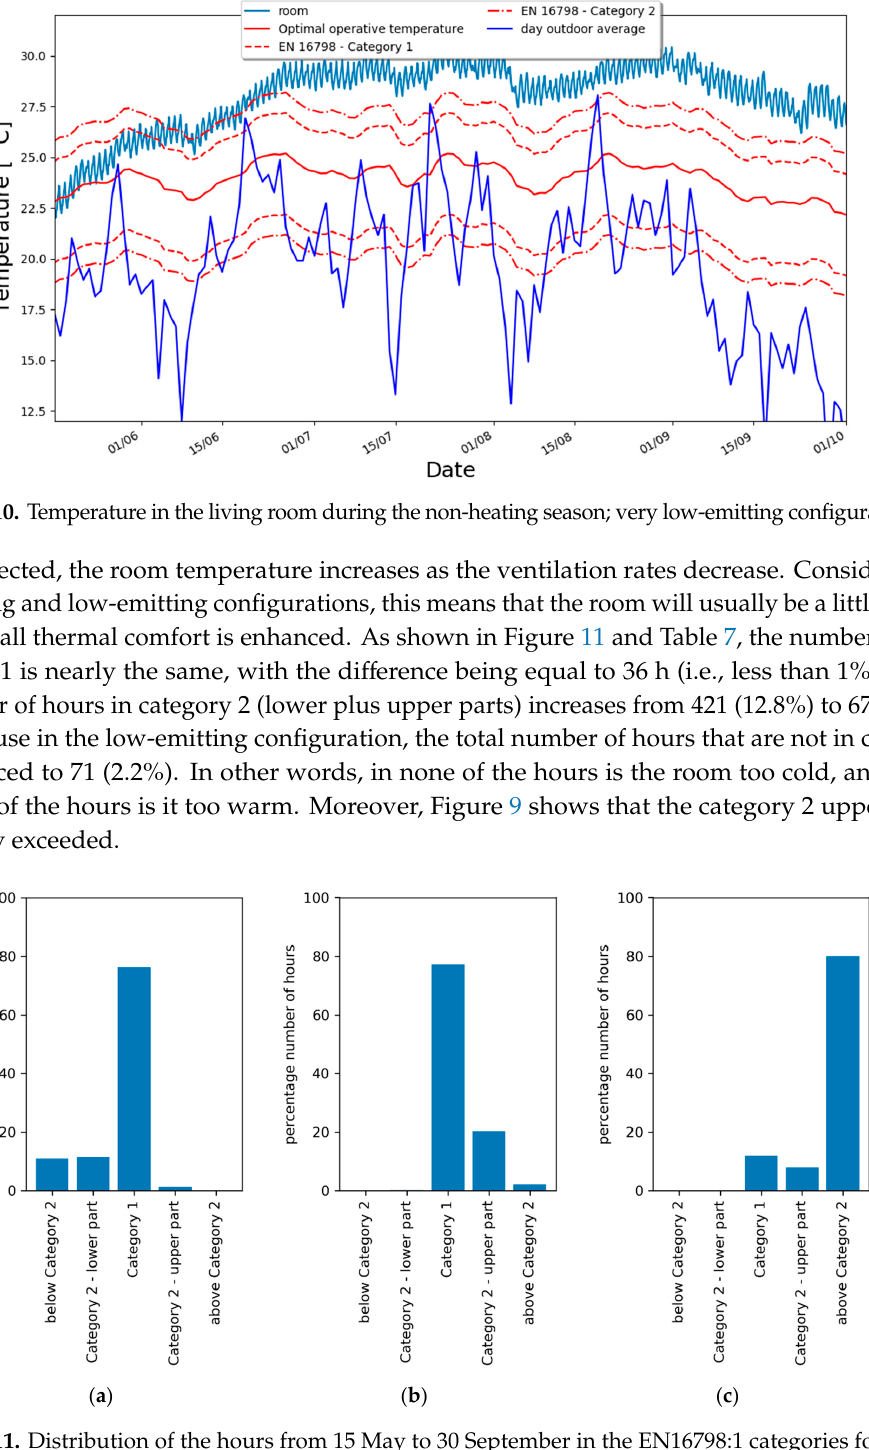
Figure 11. Distribution of the hours from 15 May to 30 September in the EN16798:1 categories for the three configurations: ( a ) high emitting, ( b ) low emitting, and ( c ) very low emitting.